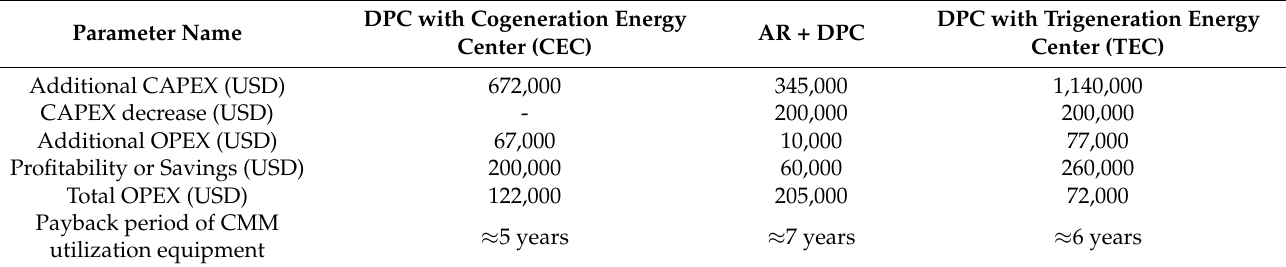
Table 4. Comparison of CMM utilization